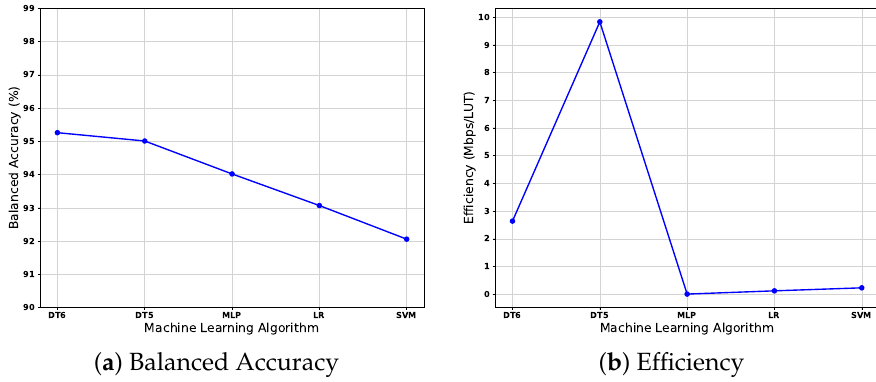
Figure 13. Trade-Off between Accuracy and